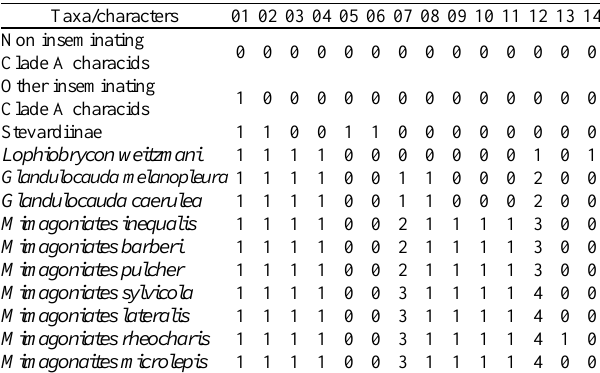
Table 1. Character state matrix for the glandulocaudine species and outgroups and characters described in “Glandulocaudine